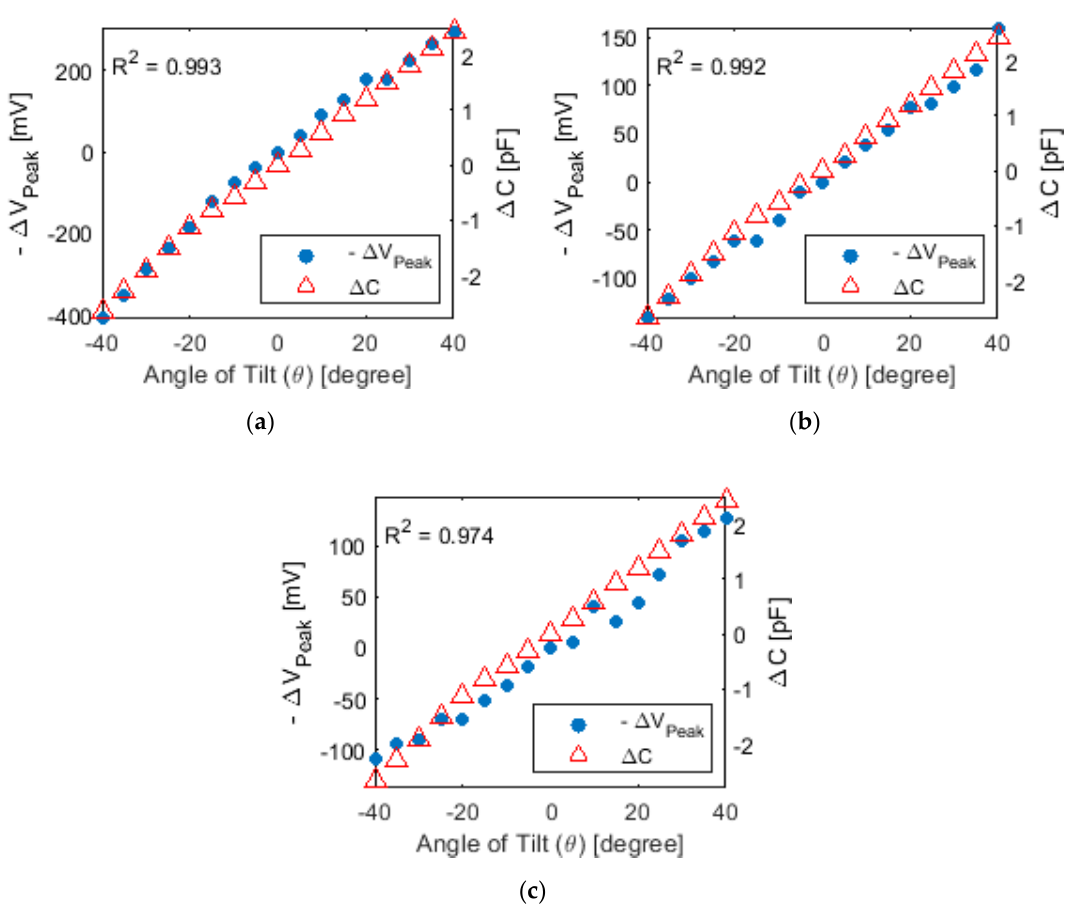
Figure 13. ETDR testing was performed using three sensors in a transmission line. The change in peak voltages of tilt sensors ( a ) #1, ( b ) #2, and ( c ) #3 for di ff erent angles of tilt are plotted. The corresponding sensor’s change in capacitance results are also overlaid in each